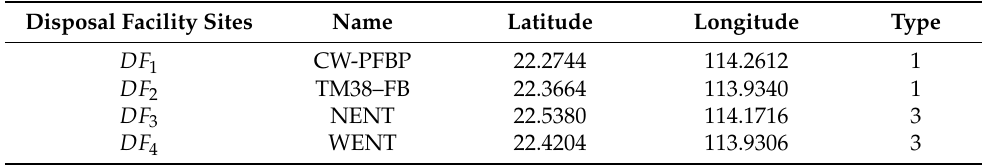
Table A1. List of the locations of all potential disposal facility